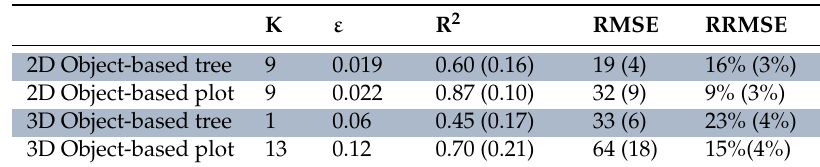
Table 2. Optimal DBSCAN parameters k and ε with accuracy metrics R 2 , RMSE and RRMSE with standard deviation between brackets for